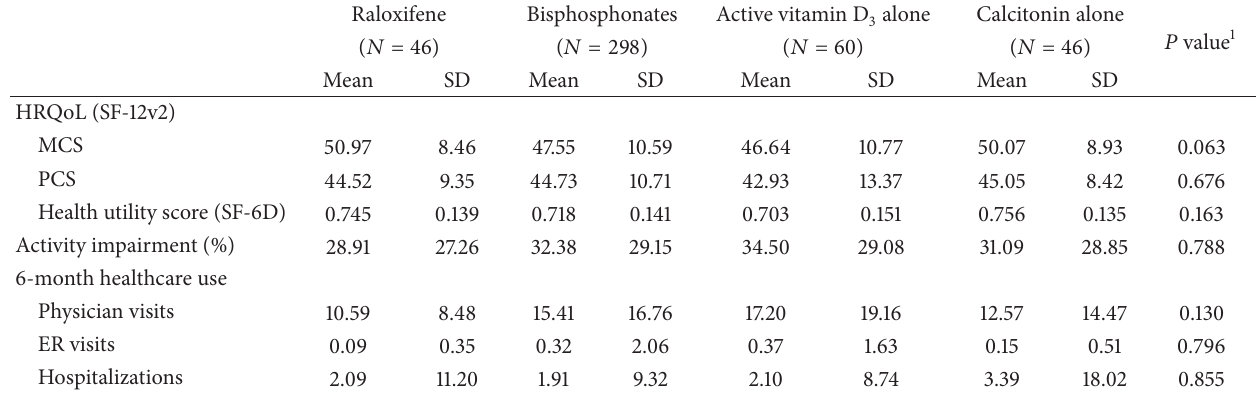
Table 4: Unadjusted mean outcomes according to type of osteoporosis treatment. Raloxifene Bisphosphonates Active vitamin D